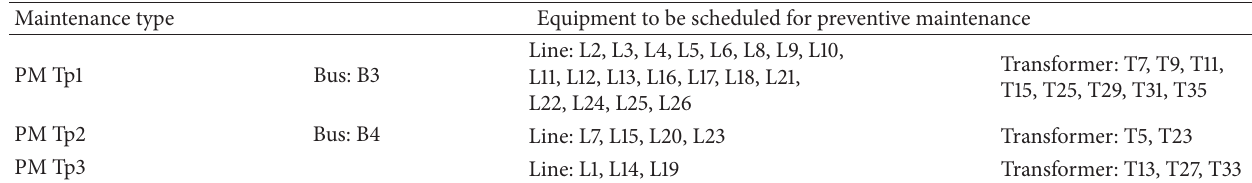
Table 3: Preventive maintenance (PM) needed equipment.